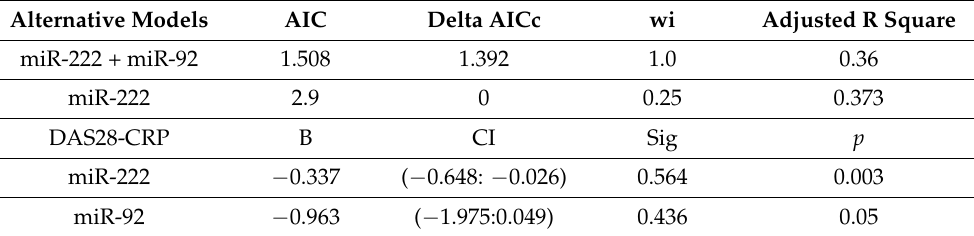
Table 3. Models of linear regression in RA with weights (wi) and adjusted R square of coefficients for DAS28-CRP.